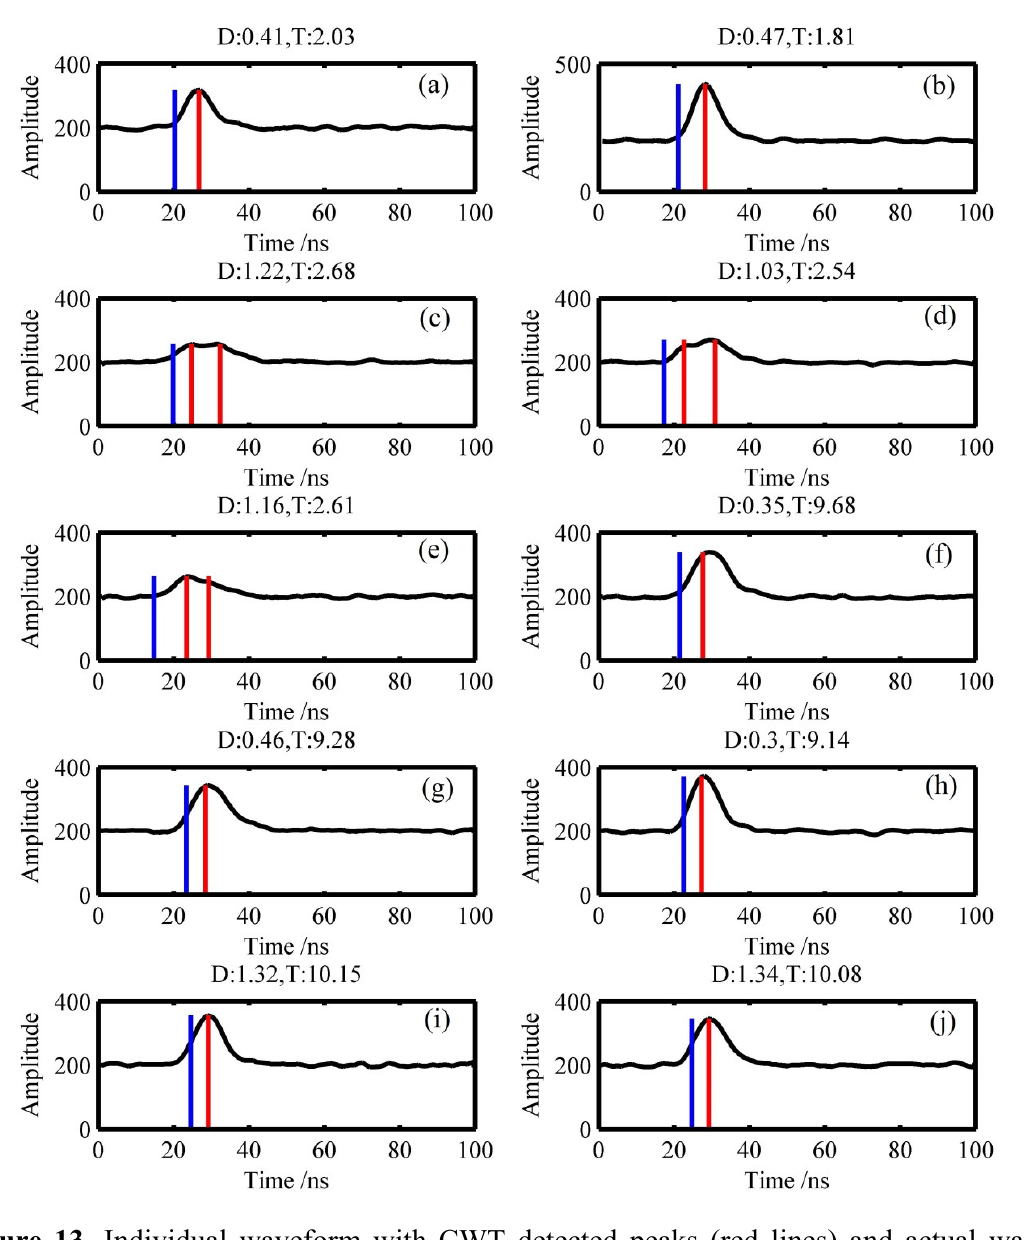
Figure 13. Individual waveform with CWT detected peaks (red lines) and actual water surface location (from RTK—black line) under different water conditions with depth (D, unit: m) and turbidity (T, unit: NTU). ( a , b ) are shallow water with lower turbidity, ( c – e ) deeper water with lower turbidity, ( f – h ) shallow water with higher turbidity, and ( i – j ) deeper water with higher